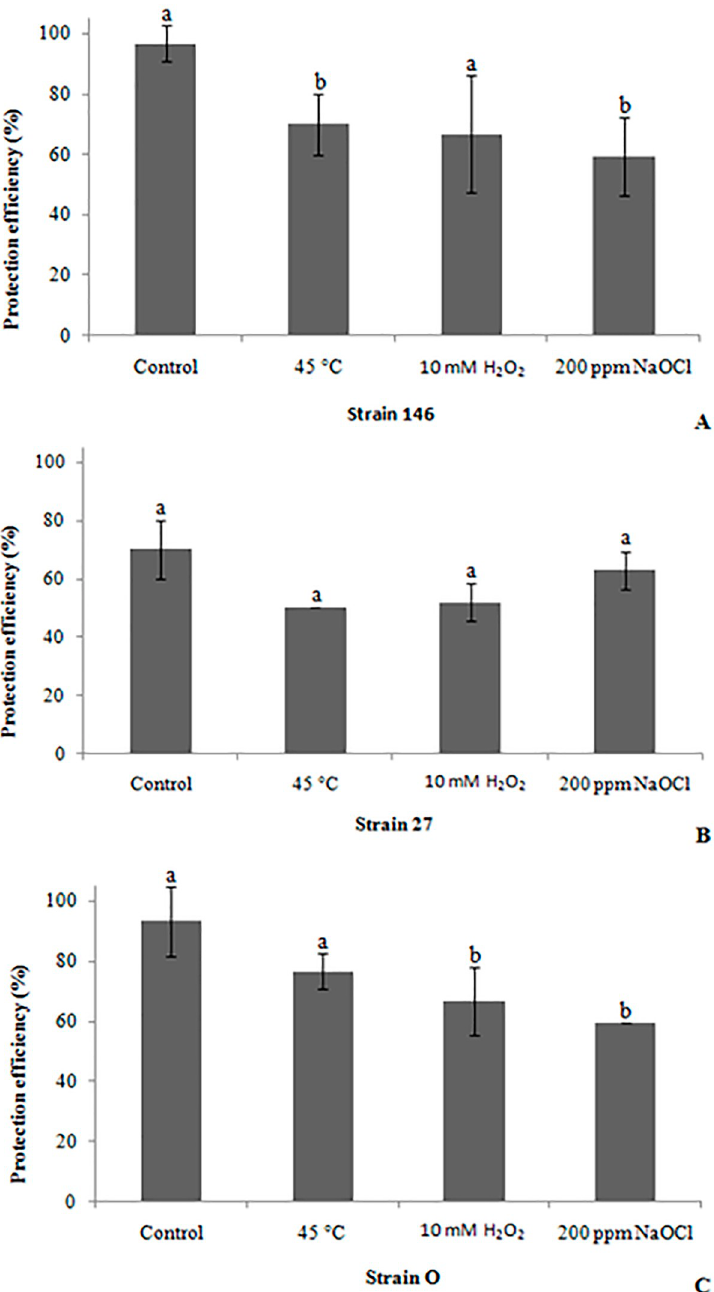
Fig 6. Biocontrol efficiency of stressed yeasts against P . digitatum . C . lusitaniae 146 (A), P . fermentans 27 (B) and C . oleophila strain O (C) were exposed to different stress factors (45˚C for 5 min, 10 mM H 2 O 2 for 15 min and 200 ppm NaOCl for 15 min) before evaluating its efficiency in controlling the pathogen. Mean values marked with identical letters are—according to the Tukey test (p < 0.05)—not significantly